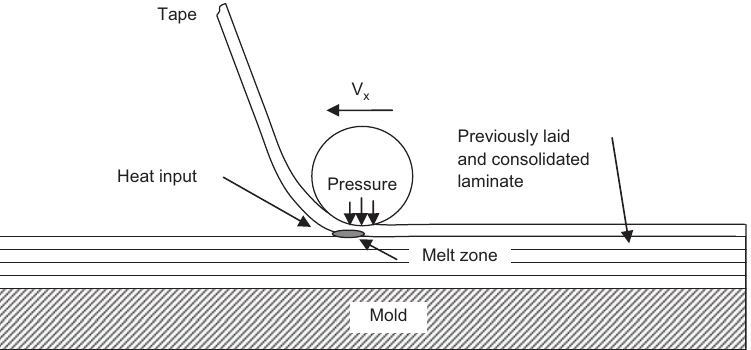
Figure 1 The automated fi ber placement process of thermoplastic